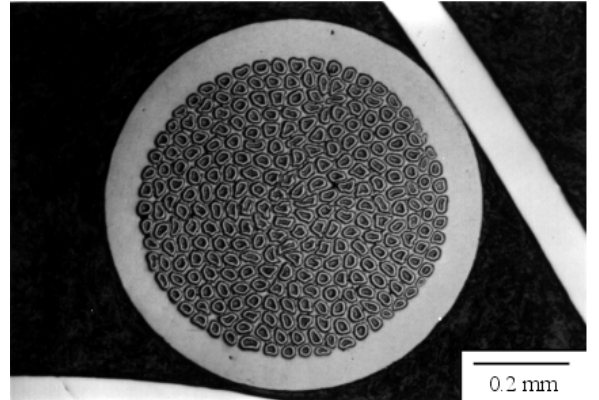
Figure 3. (Nb,Ta) 3 Sn superconductor wire with 0.81 mm and 271 fila- ments, after wire drawing. The 271 filaments are embedded in a OFHC Cu matrix, which actuate as cryogenic and electrodynamic